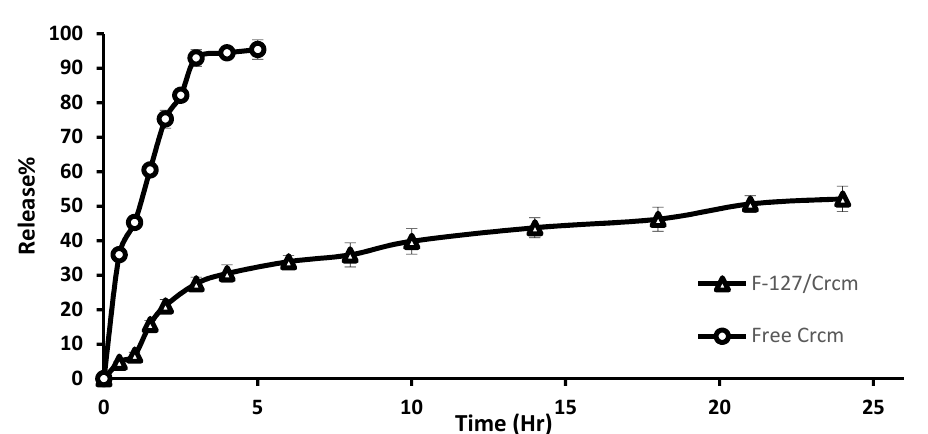
Figure 2. In vitro release of free curcumin (Crcm) and curcumin-loaded microemulsion (F-127/Crcm) at PBS 7.4/ethanol (1:1) and 37 °C after 24 h.